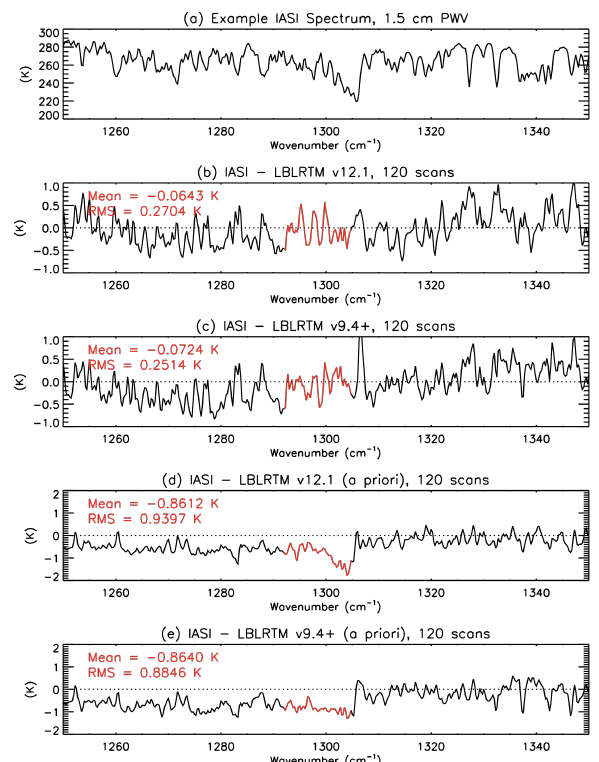
Fig. 29. (a) IASI-observed brightness temperature spectrum in the ν 4 band of CH 4 for an example profile with 1.5cm PWV. (b) Mean of the final (a posteriori) brightness temperature residuals for 120 spectra using LBLRTM v12.1. (c) Mean of the final brightness tem- perature residuals for 120 spectra using LBLRTM v9.4 + . (d) Mean of the a priori brightness temperature residuals for 120 spectra us- ing LBLRTM v12.1. (e) Mean of the a priori brightness temperature residuals for 120 spectra using LBLRTM v9.4 + . The CH 4 retrieval window is highlighted in red. Note that the RMS due to instrument noise alone in this retrieval window is 0.016K.